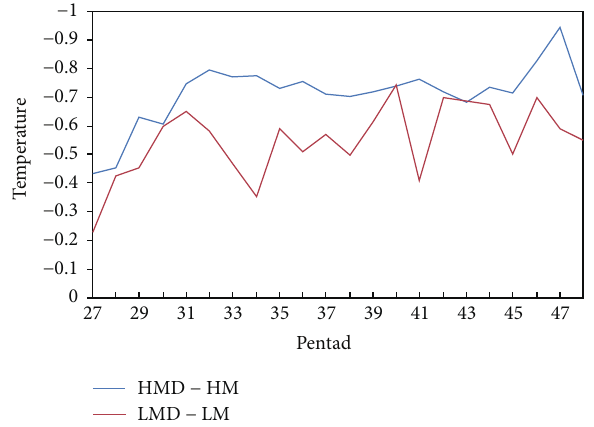
Figure 10: Regional mean atmospheric temperature ( ∘ C) change